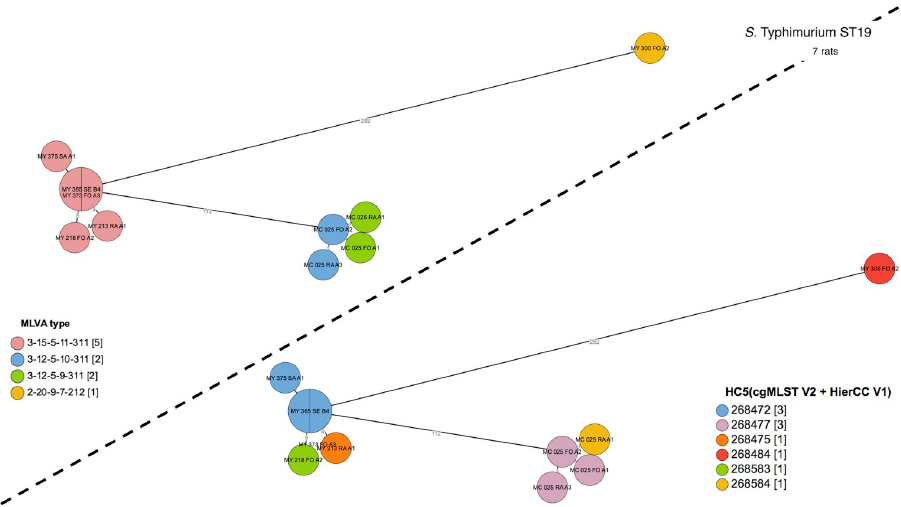
Fig 5. Clustering of S . Typhimurium ST19 rat isolates according to HC5-values (cgMLST V2 + HierCC V1, upper left) and MLVA type (lower right). Minimum spanning tree (MSTree V2) comparing all ST19 in this study. In panel A, colors are according to cgMLST HC5 values; in panel B, colors are according to MLVA type.